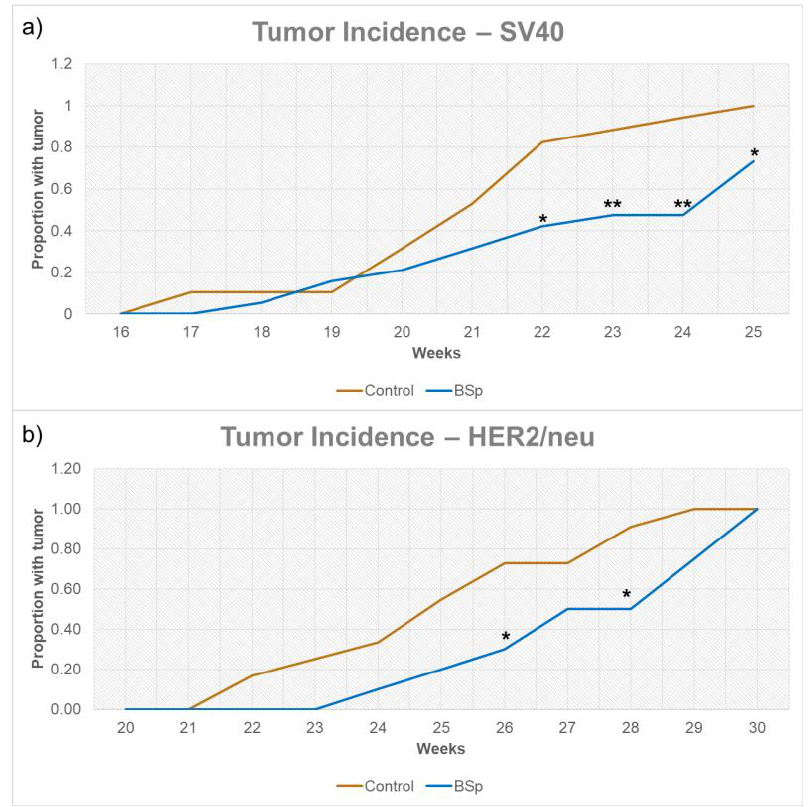
Figure 2. Tumor incidence for SV40 ( a ) and HER2/neu ( b ) mice. Tumor formation began around 16 weeks for SV40 mice and 21 weeks for HER2/neu mice. For both controls and experimental mice in both SV40 and HER2 experiments n = 24 mice. * = p < 0.05 and ** = p <